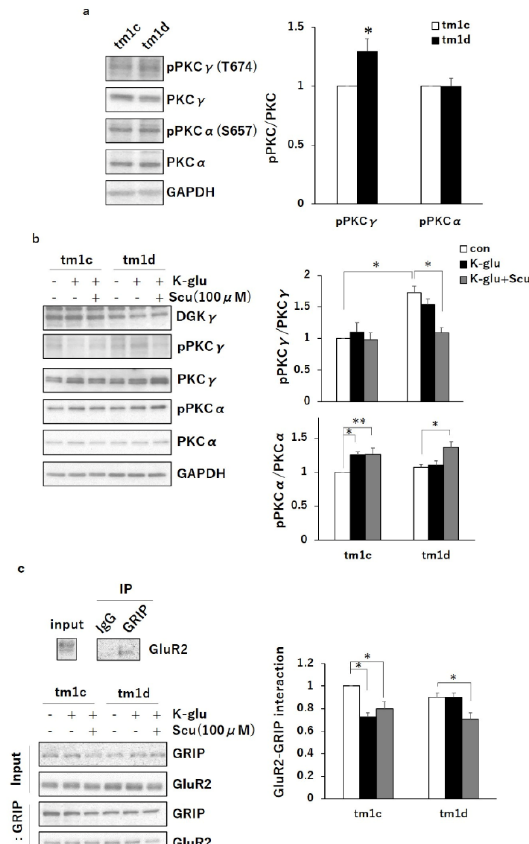
Figure 3. Protein kinase C α (PKC α ) inactivation during long-term depression (LTD)-induced stimulation by K-glu in tm1d mice: ( a ) cerebellar lysates from tm1c and tm1d mice were subjected to Western blotting and probed with anti-PKC γ , anti-PKC α , anti-phospho-PKC γ , anti-phospho-PKC α , and anti-GAPDH antibodies. Quantification of the autophosphorylation of PKC γ and PKC α was performed by ImageJ. The phosphorylation levels of PKC γ and PKC α were normalized to the PKC γ and PKC α expression levels. The ratio of phosphorylation of PKC γ and PKC α to the expression levels of PKC γ and PKC α to tm1c was plotted (PKC γ : n = 3; PKC α : n = 3); * p < 0.05, followed by Student’s t-test. ( b ) Acute cerebellar slices from tm1c and tm1d mice were incubated with or without Scu (100 µ m) for 1 h and subsequently were treated with K-glu (50 mM KCl + 100 µ M L-glutamate) for 5 min. Lysates from the slices were subjected to Western blotting and probed with anti-DGK γ , anti-phospho-PKC γ , anti-PKC γ , anti-phospho-PKC α , anti-PKC α , and anti-GAPDH antibodies. Quantification of the autophosphorylation of PKC γ and PKC α was performed by ImageJ. The phosphorylation levels of PKC γ and PKC α were normalized to the PKC γ and PKC α expression levels. The ratio of phosphorylation of PKC γ and PKC α to the control (con) in tm1c was plotted (n = 6); * p < 0.05, ** p < 0.01, followed by Tukey’s multiple comparisons test. ( c ) The lysates after K-glu treatment were immunoprecipitated using anti-glutamate receptor interacting protein (GRIP) antibody. The immunoprecipitates were subjected to western blotting and probed with anti-GRIP and anti-GluR2 antibodies. IgG (anti-transient receptor potential cation channel type 3 (TRPC3) antibody) was used as a control. Quantification of co-immunoprecipitated GluR2 was performed by ImageJ and was normalized to the input level of GluR2. The ratio of the co-immunoprecipitated GluR2 to the control (con) in tm1c was plotted (n = 6); * p < 0.05, followed by Tukey’s multiple comparisons test. Data are expressed as mean ± SEM. Con means